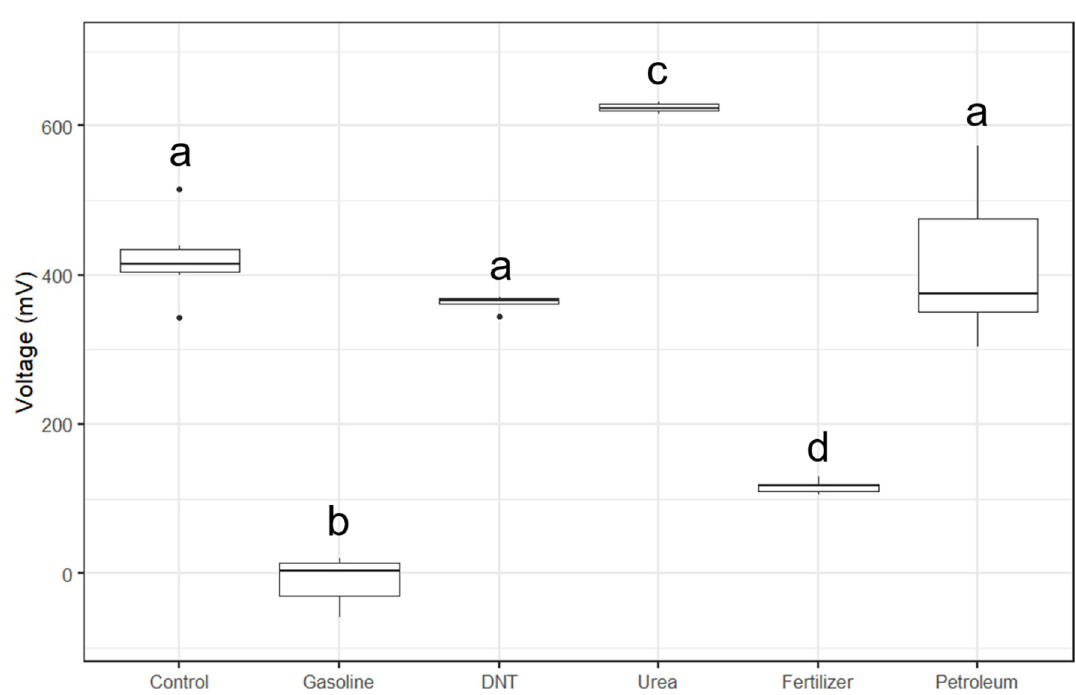
Fig 4. Boxplots of end state voltage data across the six treatments (control, gasoline, DNT, urea, fertilizer, or petroleum). Each treatment has sample size n = 6.